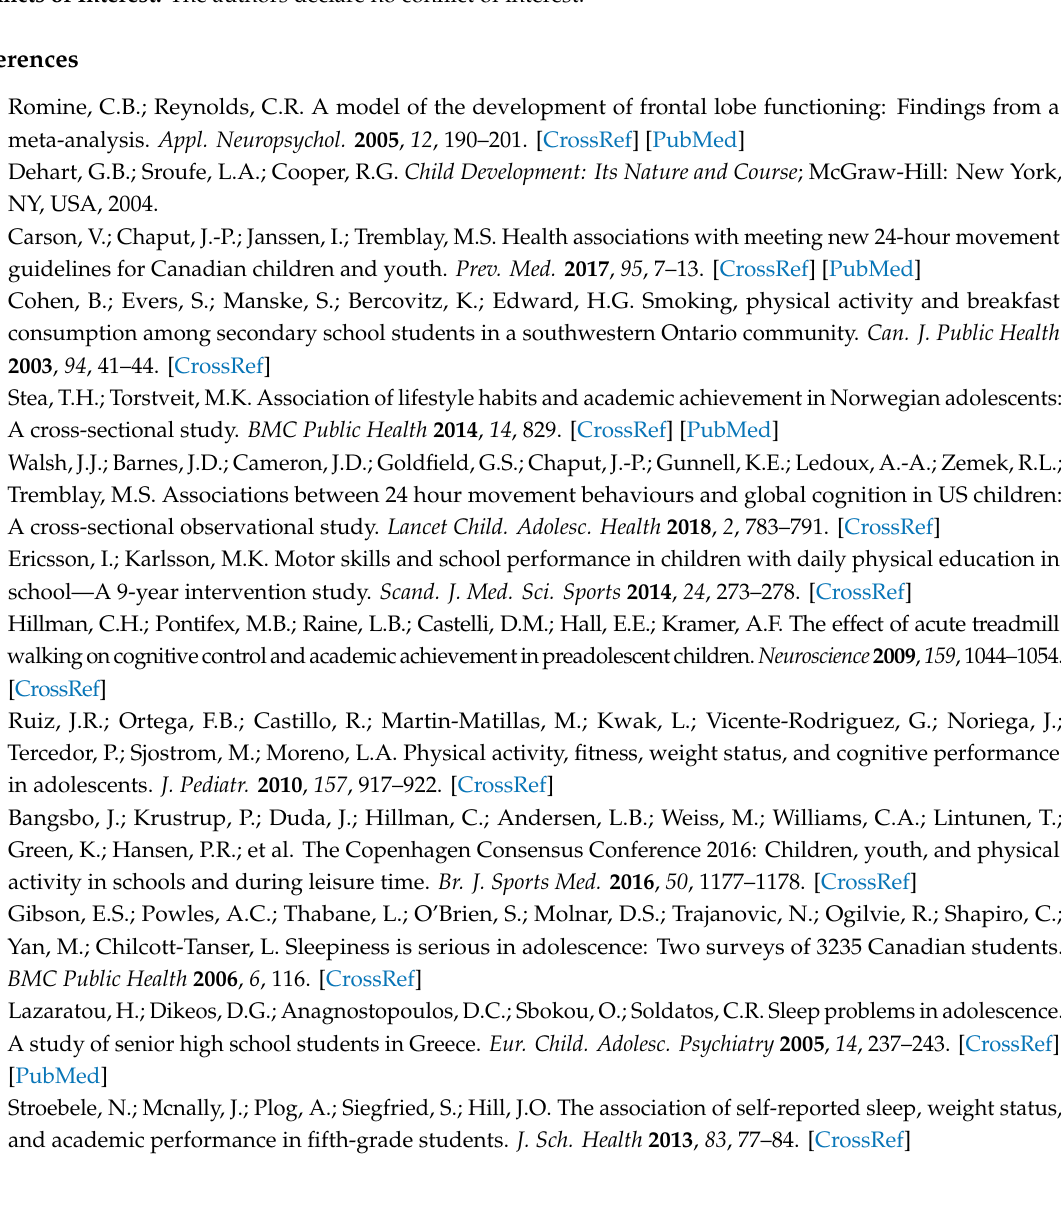
Table S1: Hierarchical regression analysis regarding independent predictors of cognitive control in high school female students, Table S2: Hierarchical regression analysis regarding independent predictors of cognitive control in high school male students, Table S3: Hierarchical regression analysis regarding independent predictors of academic performance in high school female students, Table S4: Hierarchical regression analysis regarding independent predictors of academic performance in high school male